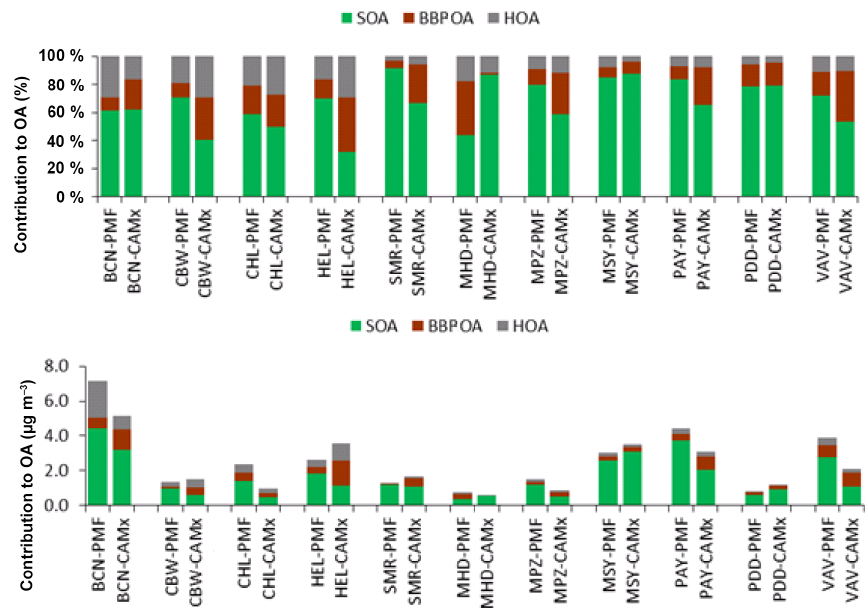
Figure 6. Relative (upper panel) and absolute (lower panel) contribution of HOA, BBPOA and SOA to OA concentrations at 11 sites from PMF analysis of AMS measurements (first bar) and CAMx VBS_BC_NEW results (second bar) for the period between 25 February and 26 March 2009.